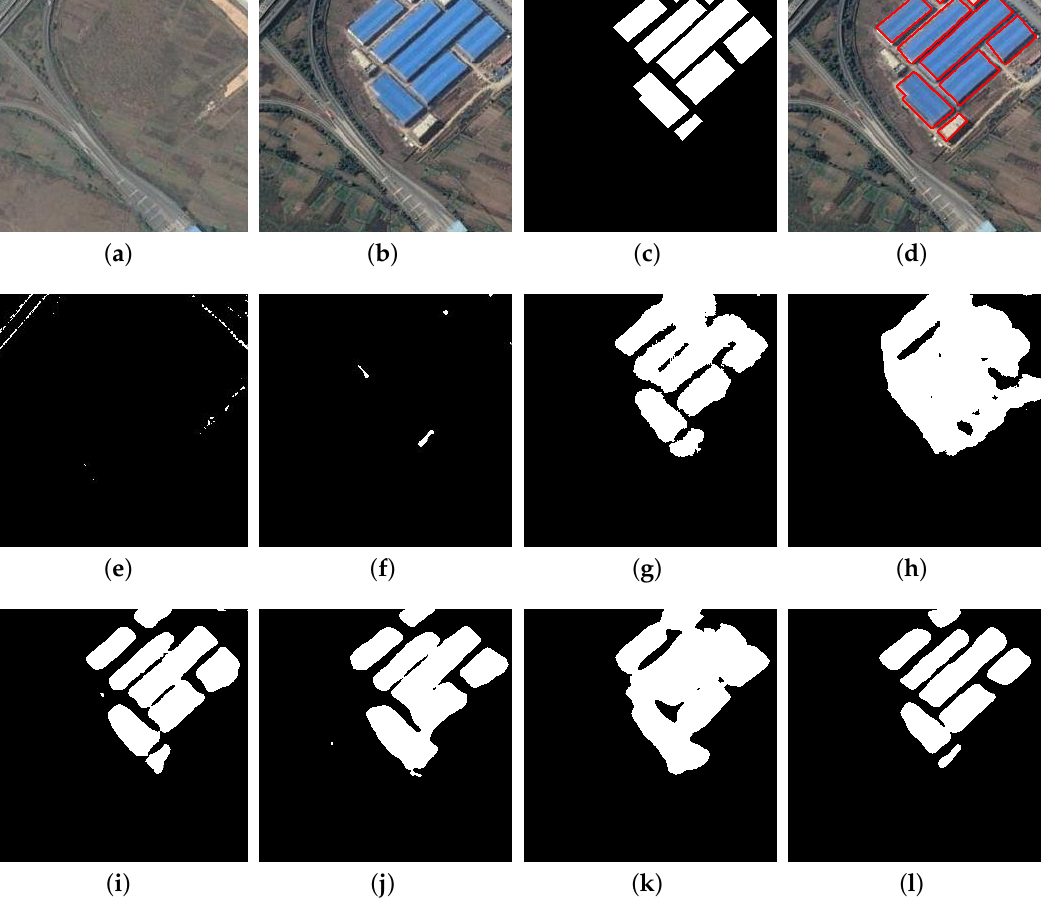
Figure 12. Comparison of prediction maps for different algorithms. Panels ( a , b ) are Google Earth images of the same place at different times. Panel ( c ) is the ground truth, in which the black areas represent the unchanged, and the white areas represent the changed. The changed areas are framed by red lines in panel ( d ). Panels ( e – l ) are the prediction maps of different algorithms, which are, respectively, ( e ) IR-MAD, ( f ) PCA-means, ( g ) SegNet, ( h ) FCN8S, ( i ) HRNet, ( j ) UNet, ( k ) UNet_att, and ( l )